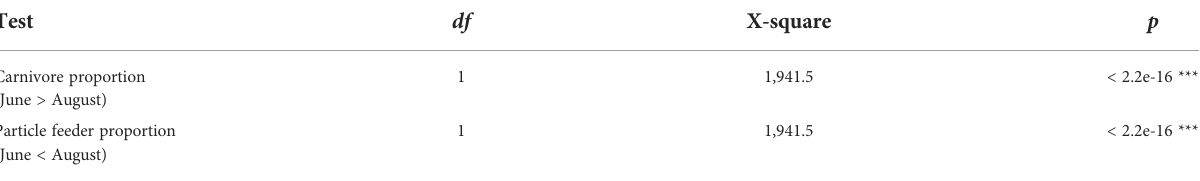
TABLE 3 Results of chi-square test (feeding habits between before and after